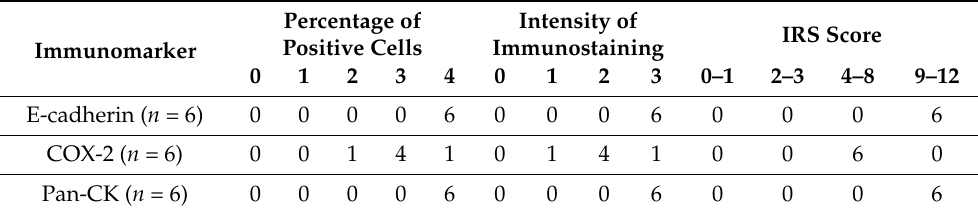
Table 3. Six keratoacanthomas from lizards ( n = 6) were categorized according to the percentage of positive cells (0–4), the intensity of immunostaining (0–3), and the IRS score (0–12) (Table 2) for e-cadherin, cyclooxygenase-2 (COX-2), and pan-cytokeratin